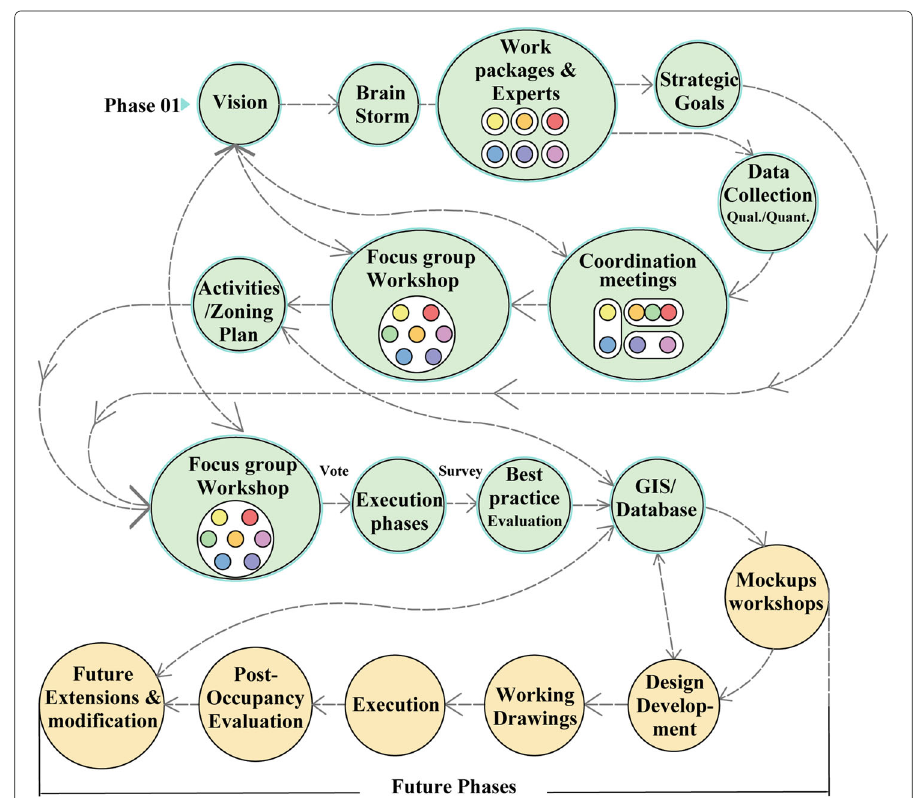
Fig. 7 The NRIAG Park participatory design process